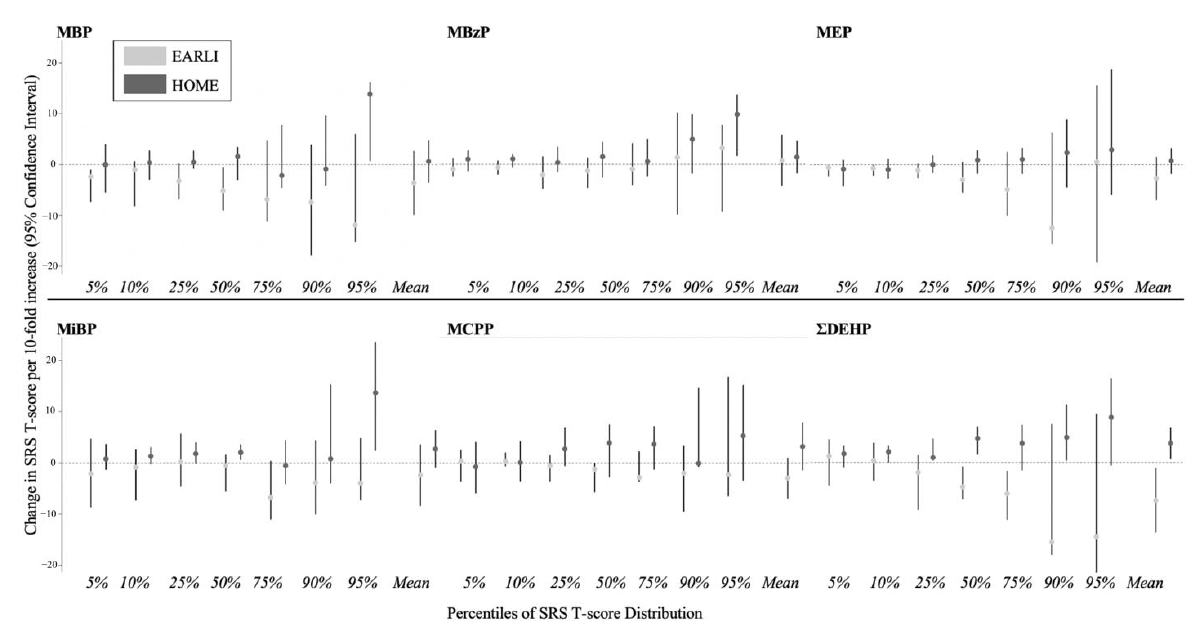
Figure 3. Adjusted differences in child SRS T-scores at 3 to 8 years per 10-fold increase in gestational maternal urinary phthalate metabolite concentrations: the EARLI (2009–2012) and HOME Studies (2003–2006). EARLI: Early Autism Risk Longitudinal Investigation Study, HOME: Health Outcomes and Measures of the Environment Study, SRS: Social Responsiveness Scale. MCPP, mono(3-carboxypropyl) phthalate; MiBP, mono-isobutyl phthalate; MBzP, monobenzyl phthalate; MBP, mono-n-butyl phthalate; ΣDEHP, summary di(2-ethylhexyl) phthalate metabolite measure; MEP, monoethyl phthalate. Concentrations of ΣDEHP (in ng/mL) were calculated using the following formula: ΣDEHP (ng/mL) = [MECPP (ng/mL)/278 g/mol + MEHHP (ng/mL)/294.3 g/mol + MEOHP (ng/mL)/292.2 g/mol + MEHP (ng/mL)/278.3 g/mol] × 278 g/mol. Adjusted for maternal age (continuous), maternal race (white vs. non-white), income (<$30,000 vs. $30,000– $75,000, ≥$75,000), parity (continuous), and log10-transformed urine/serum cotinine concentrations (continuous). Note cotinine concentrations were measured in maternal urine in EARLI and serum in HOME. Positive coefficients for SRS indicate that maternal phthalate exposure is associated with more deficits in social responsiveness traits. Mean values represent effect measures from linear regression analyses. Note that values may appear to differ slightly from those re- ported in Table S6, as we used un-rounded values to generate these figures. Phthalate metabolites are ordered based on median concentration values from left (lowest median concentrations) to right (highest median concentrations).